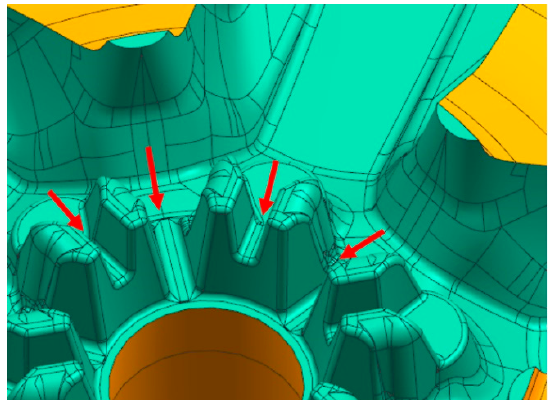
Figure 17. Geometric features of the bottom die for producing the bolt holes in the wheel in Die-A.